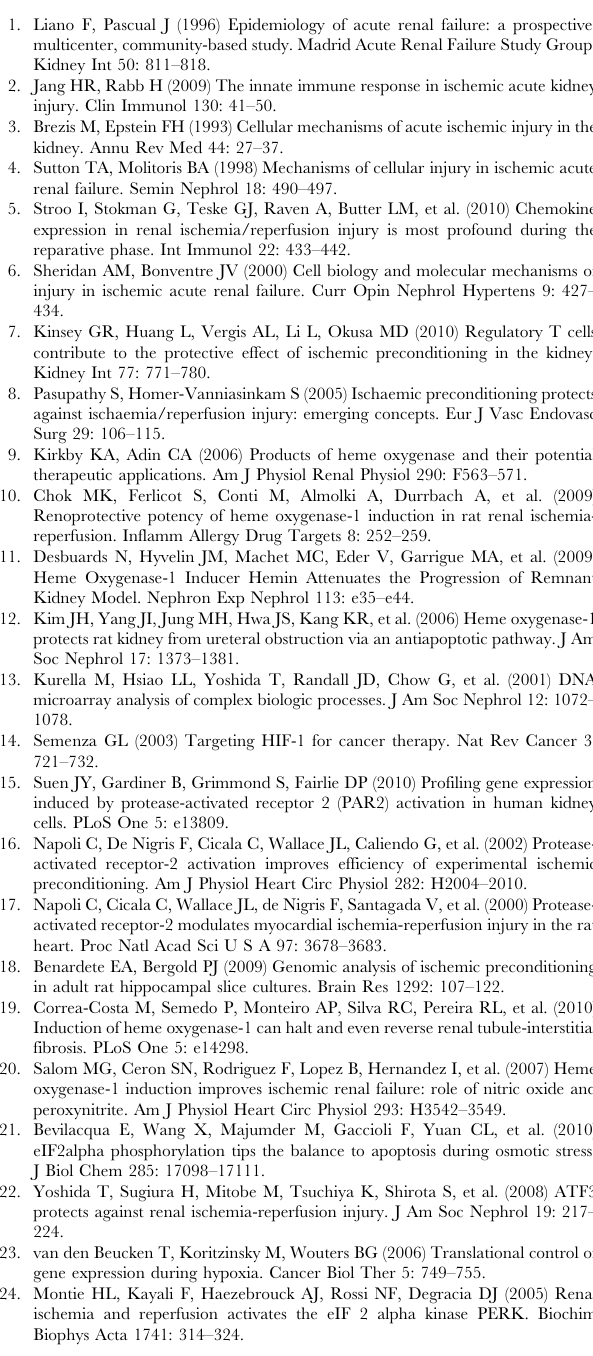
Table S14 Up regulated genes in Hemin group (vs control), according to GO and KEGG categories. Table S15 List of selected genes used for microarray results validation by